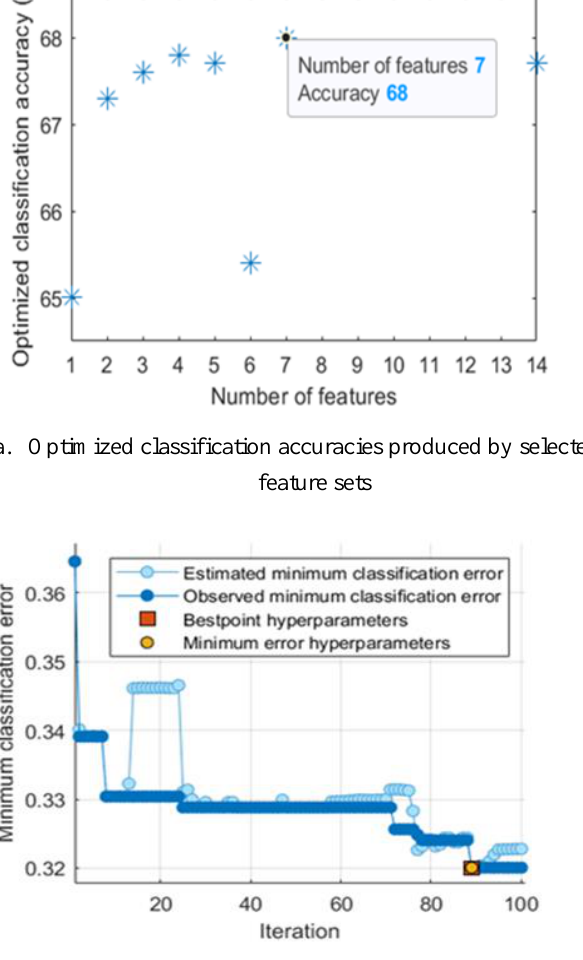
Fig. 1. SVM classification of MI based on work